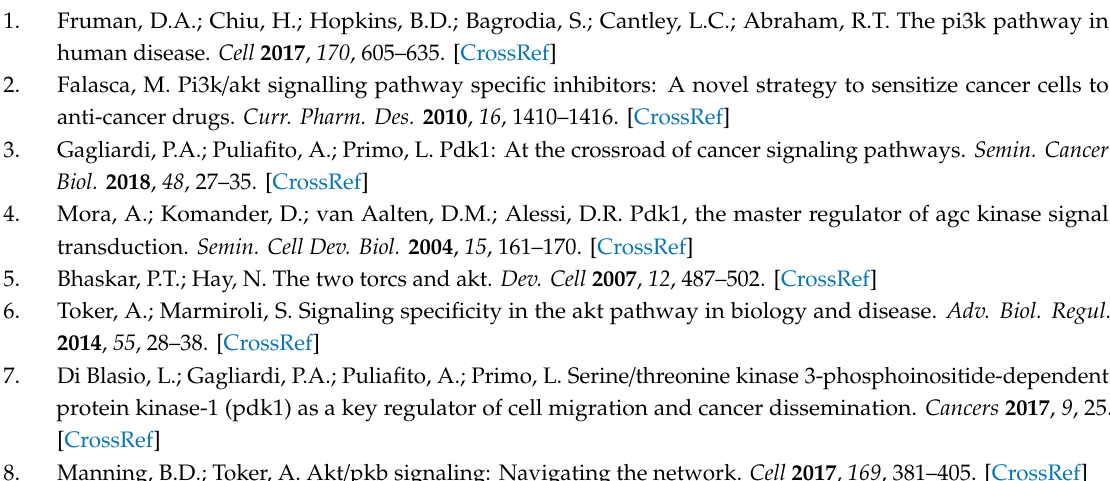
Figure S1: Inhibitory e ff ect on SA16 and IB35 on Aurora kinase B, Figure S2: Representative images of wound healing assay in BxPC-3 cells treated with SA16 and IB35 from Incucyte ZOOM TM assay, Figure S3: Representative image of a xenograft NOD / SCID mouse treated with IB35 showing the compound deposition on internal organs as evidence of poor solubility and clearance. L, liver; S,